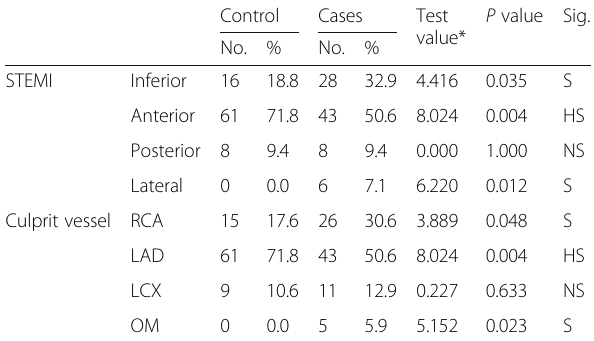
Table 3 Comparison between cases and controls regarding STEMI territory and culprit vessel P value Sig. Control Cases Test value*